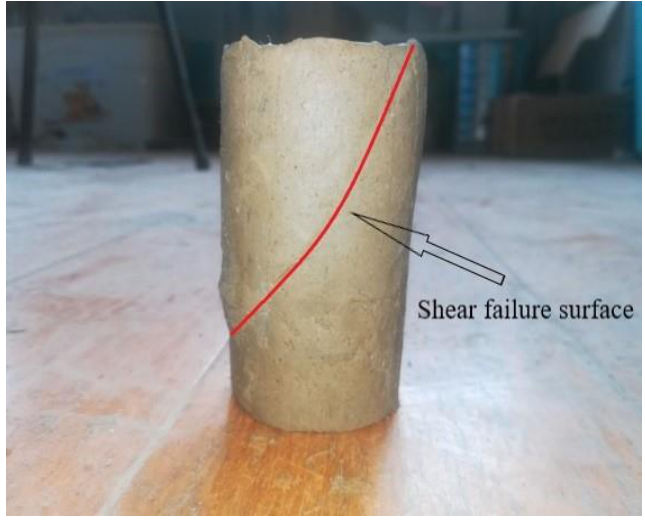
Figure 6. Failure of diatomite soil sample.